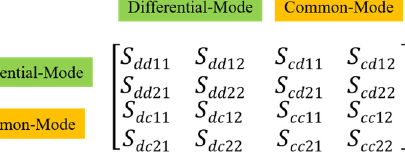
Figure 1. Mixed-mode S-parameters.